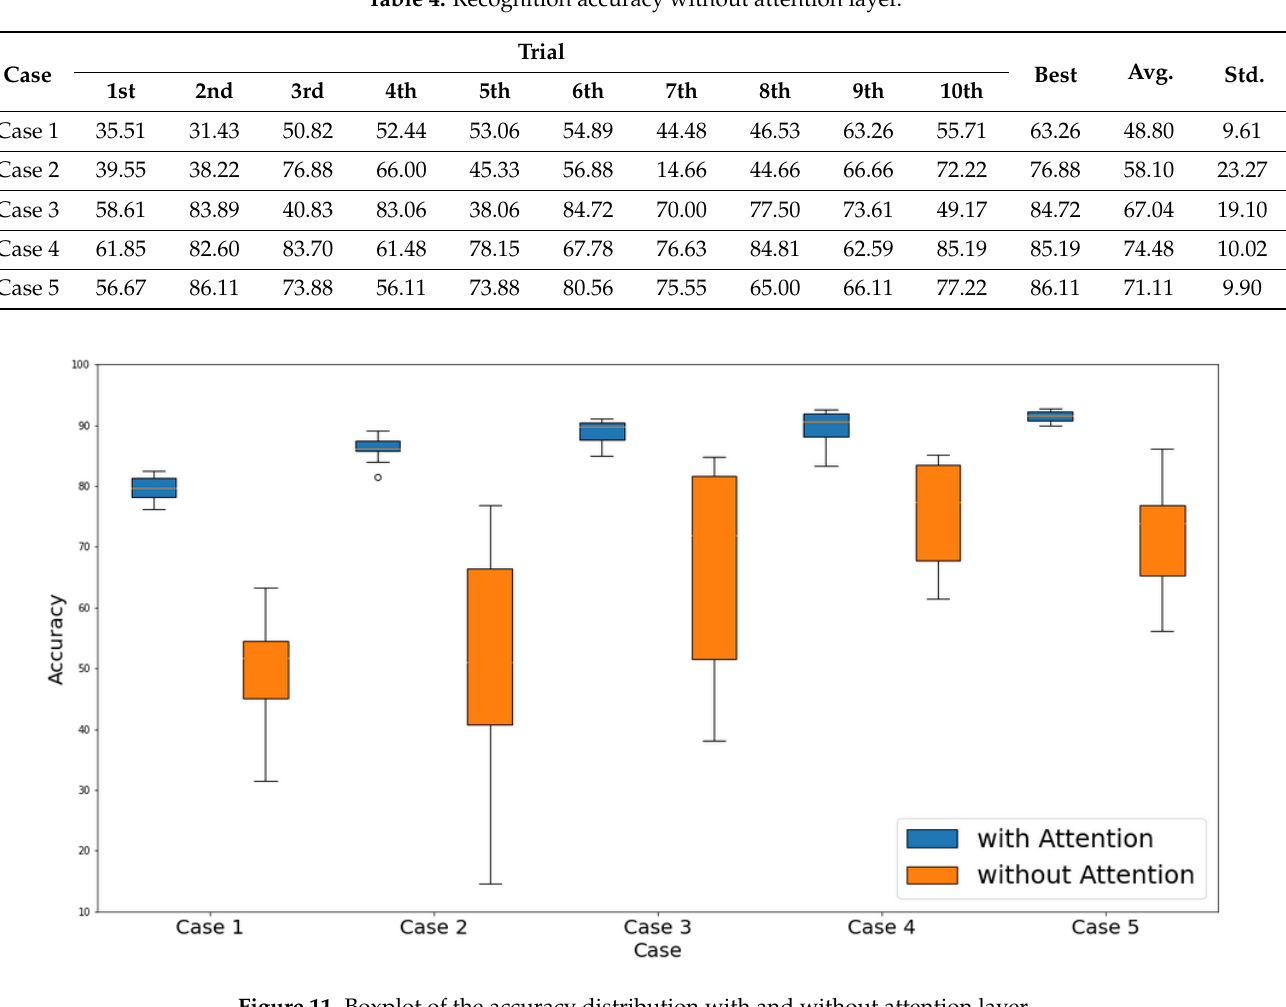
Table 5. Results of five ensemble models.